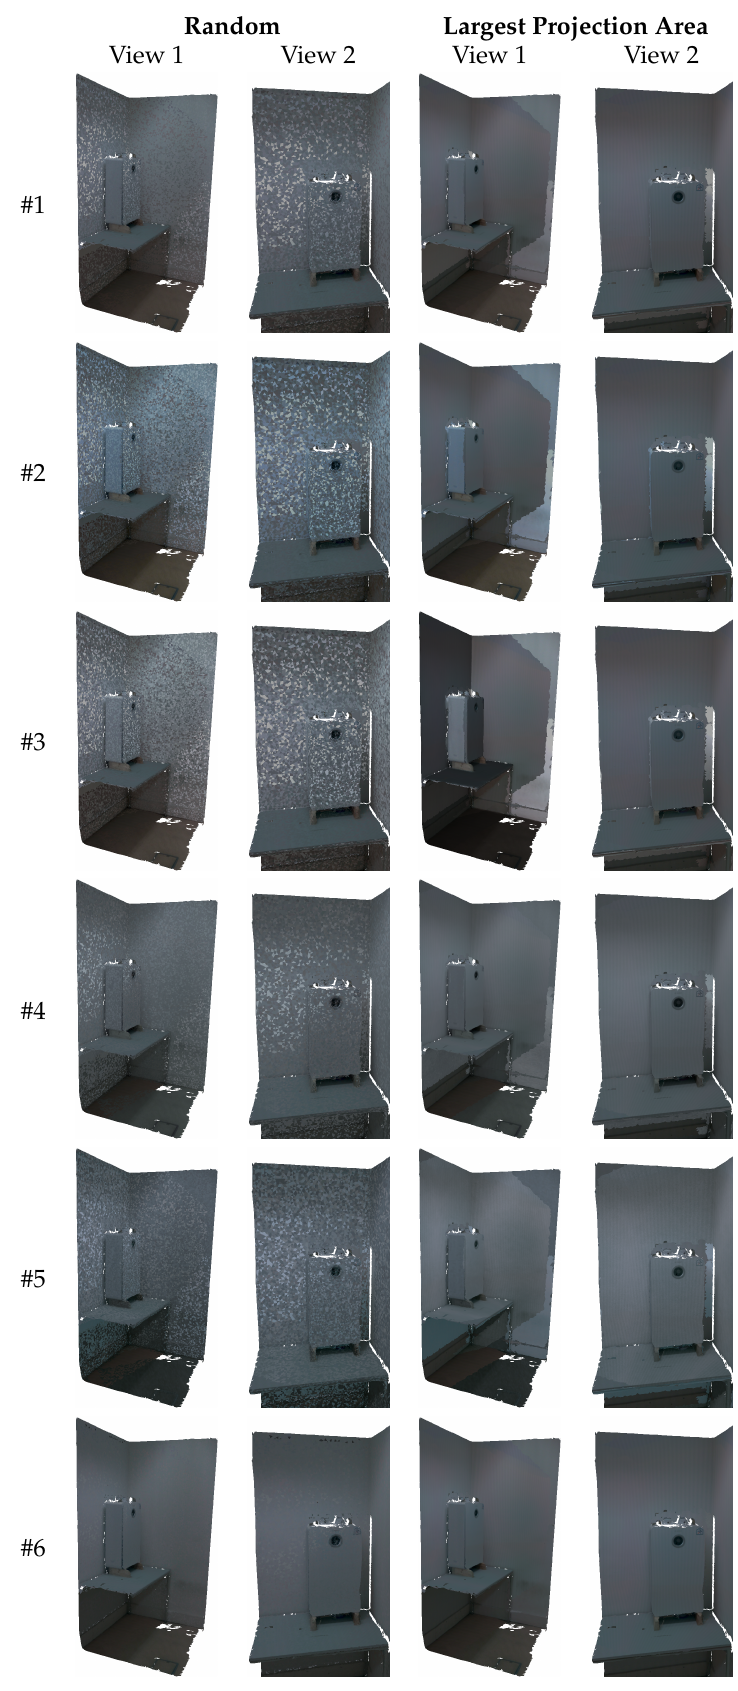
Figure 11. Textured meshes produced by each approach from two different viewpoints and using two different image selection techniques: random selection and largest projection area